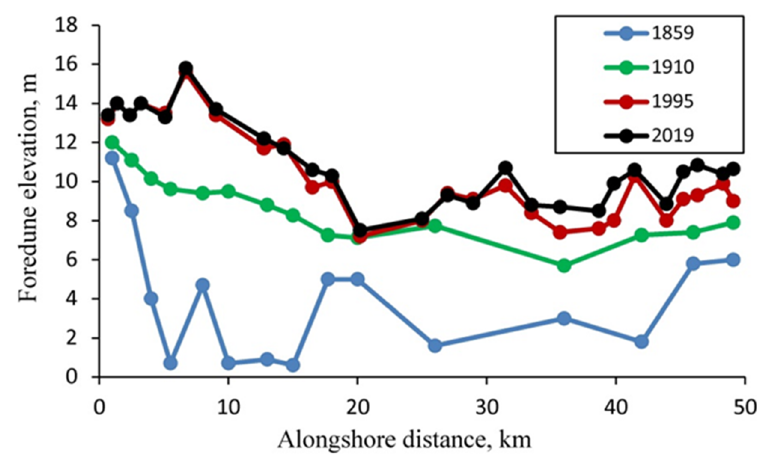
Figure 6. Changes in foredune elevation since 1859. Distance from Klaipėda port jetties.